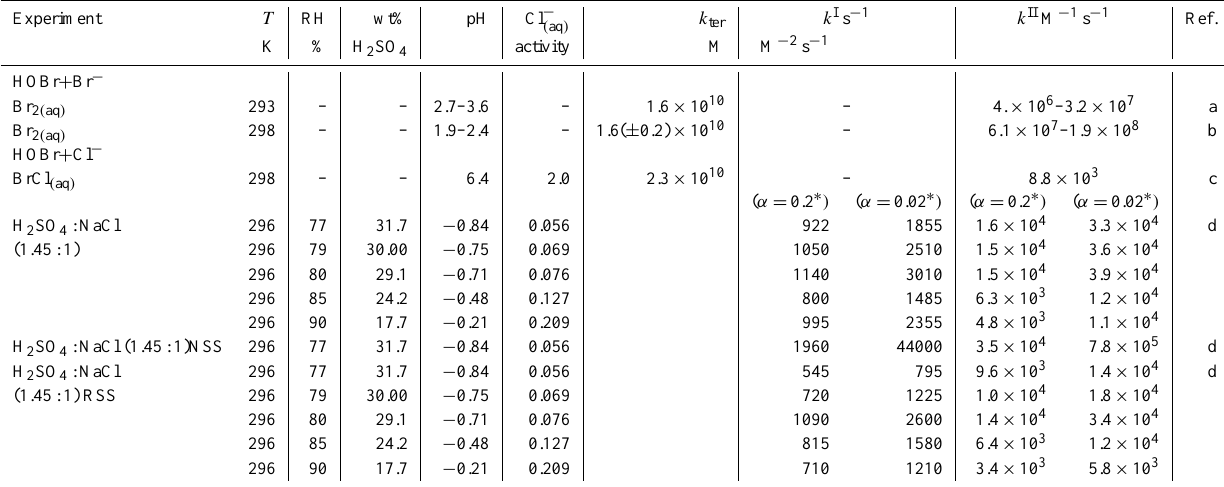
Table 2. Extraction of second-order rate constant values, k II from reported experimental data. For HOBr + Br, k II is derived from reported termolecular rate constants using k II = k ter · [H + k ter · [H + ] and from reported first-order rate constant data, k I using k II = k I / [Cl − ( aq ) calculated using the E-AIM model at 298.15K. See Sect.2.